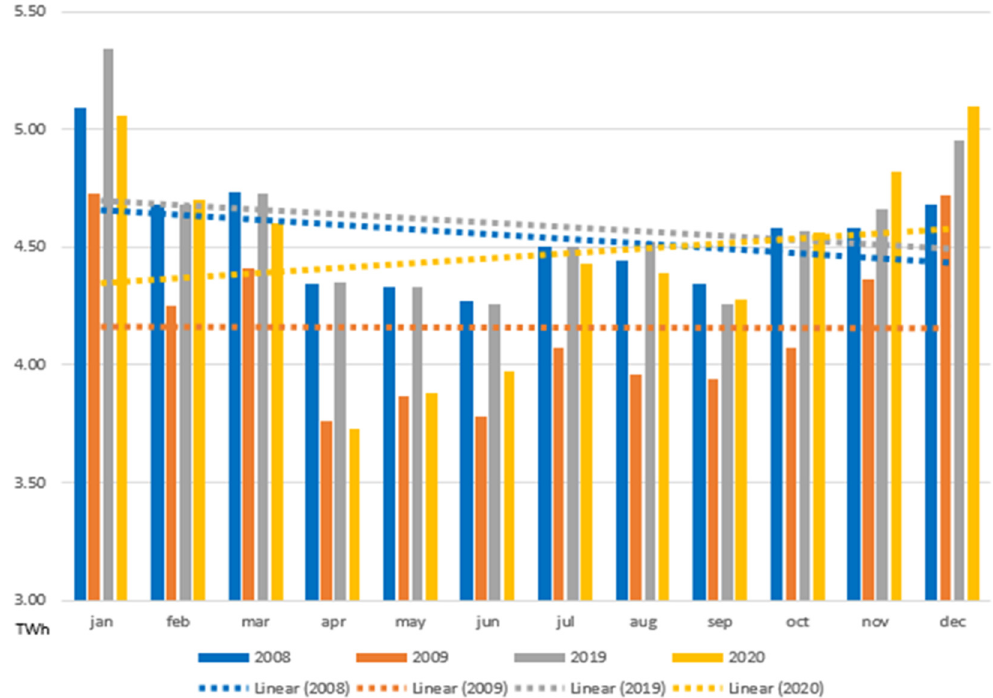
Figure 7. Comparative evolution of monthly domestic electricity consumption (DEC) during the financial crisis vs. the COVID-19 crisis.